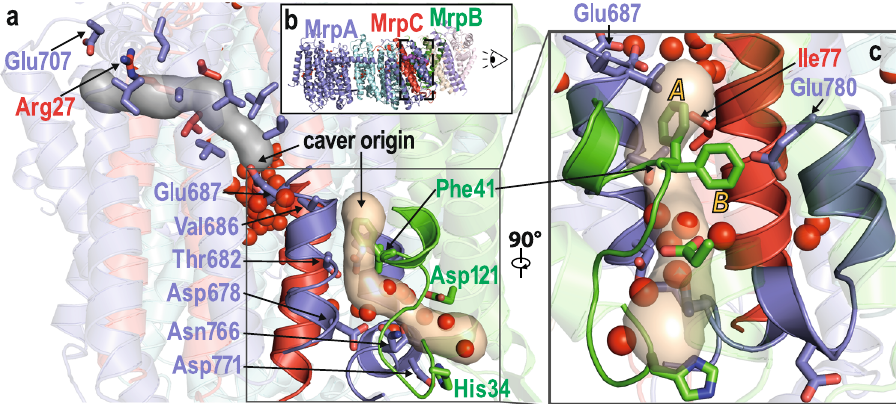
Fig.3| Putativesodiumtransferpathways.a SliceviewoftheC-terminaldomain of MrpA asindicatedin ( b ).Tunnels identi fi edwith a minimal probe radius of 1.2Å originating at Glu687 MrpA (gray) and above Phe41 MrpB (wheat) are shown in surface view at 20% transparency. The gray tunnel starts at the central water axis around W18 to W31 and terminates at the cytoplasmic side close to Glu707 MrpA and Arg27 MrpC . The tunnel is lined by several hydrophobic and poorly conserved resi- dues (Ile650 MrpA , Ala656 MrpA , Val657 MrpA , Val660 MrpA , Val691 MrpA , Leu694 MrpA , Leu704 MrpA , Leu26 MrpC , and Val30 MrpC ). The wheat-colored tunnel originates above Phe41 MrpB at the level of Glu687 MrpA but is separated from this residue by